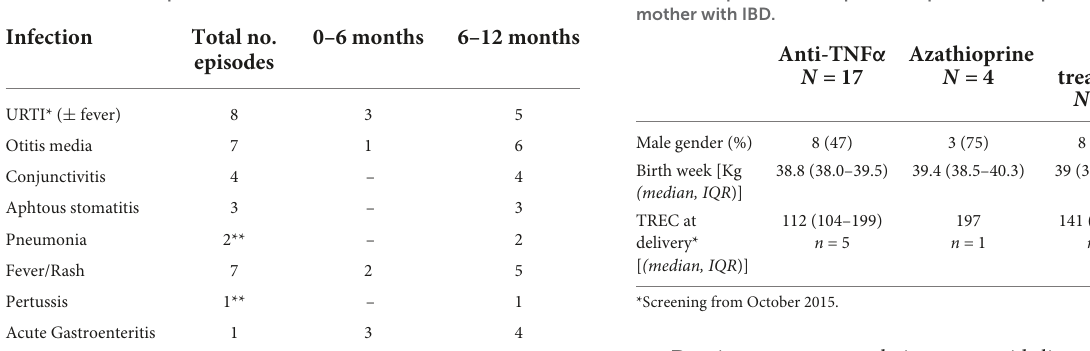
TABLE 3 Acquired infections of the newborns during 12 months follow-up.